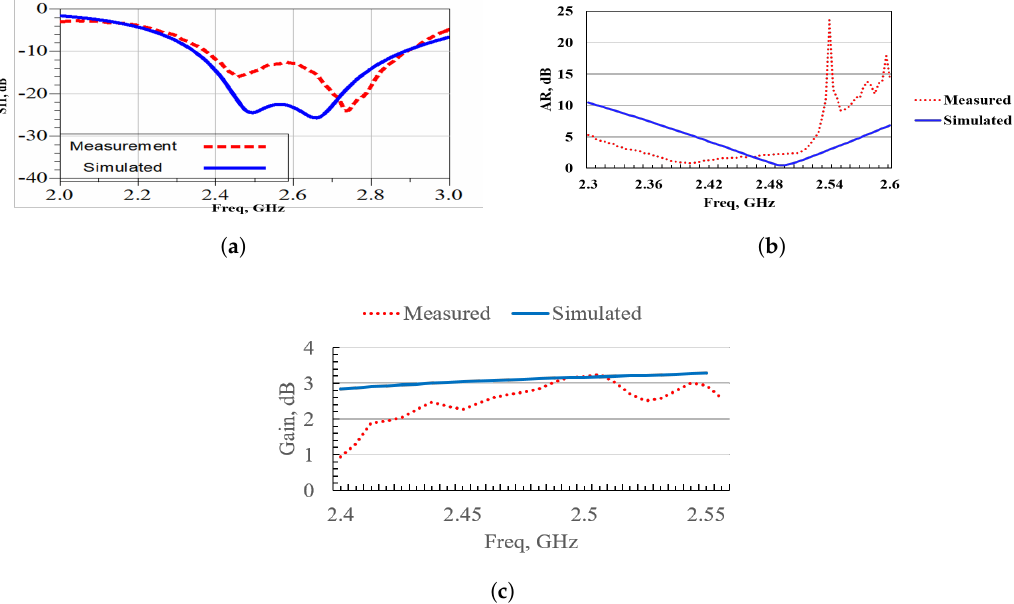
Figure 6. The measurement and simulation characteristics of the slot antenna ( a ) return loss S 11 ; ( b ) axial ratio AR ; ( c ) antenna